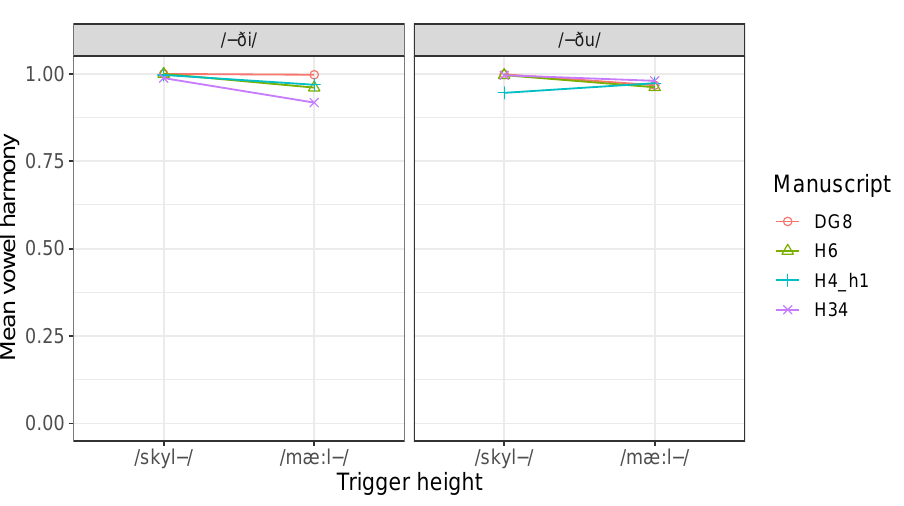
Figure 9: Categorical harmony in non-levelling, pre-decay